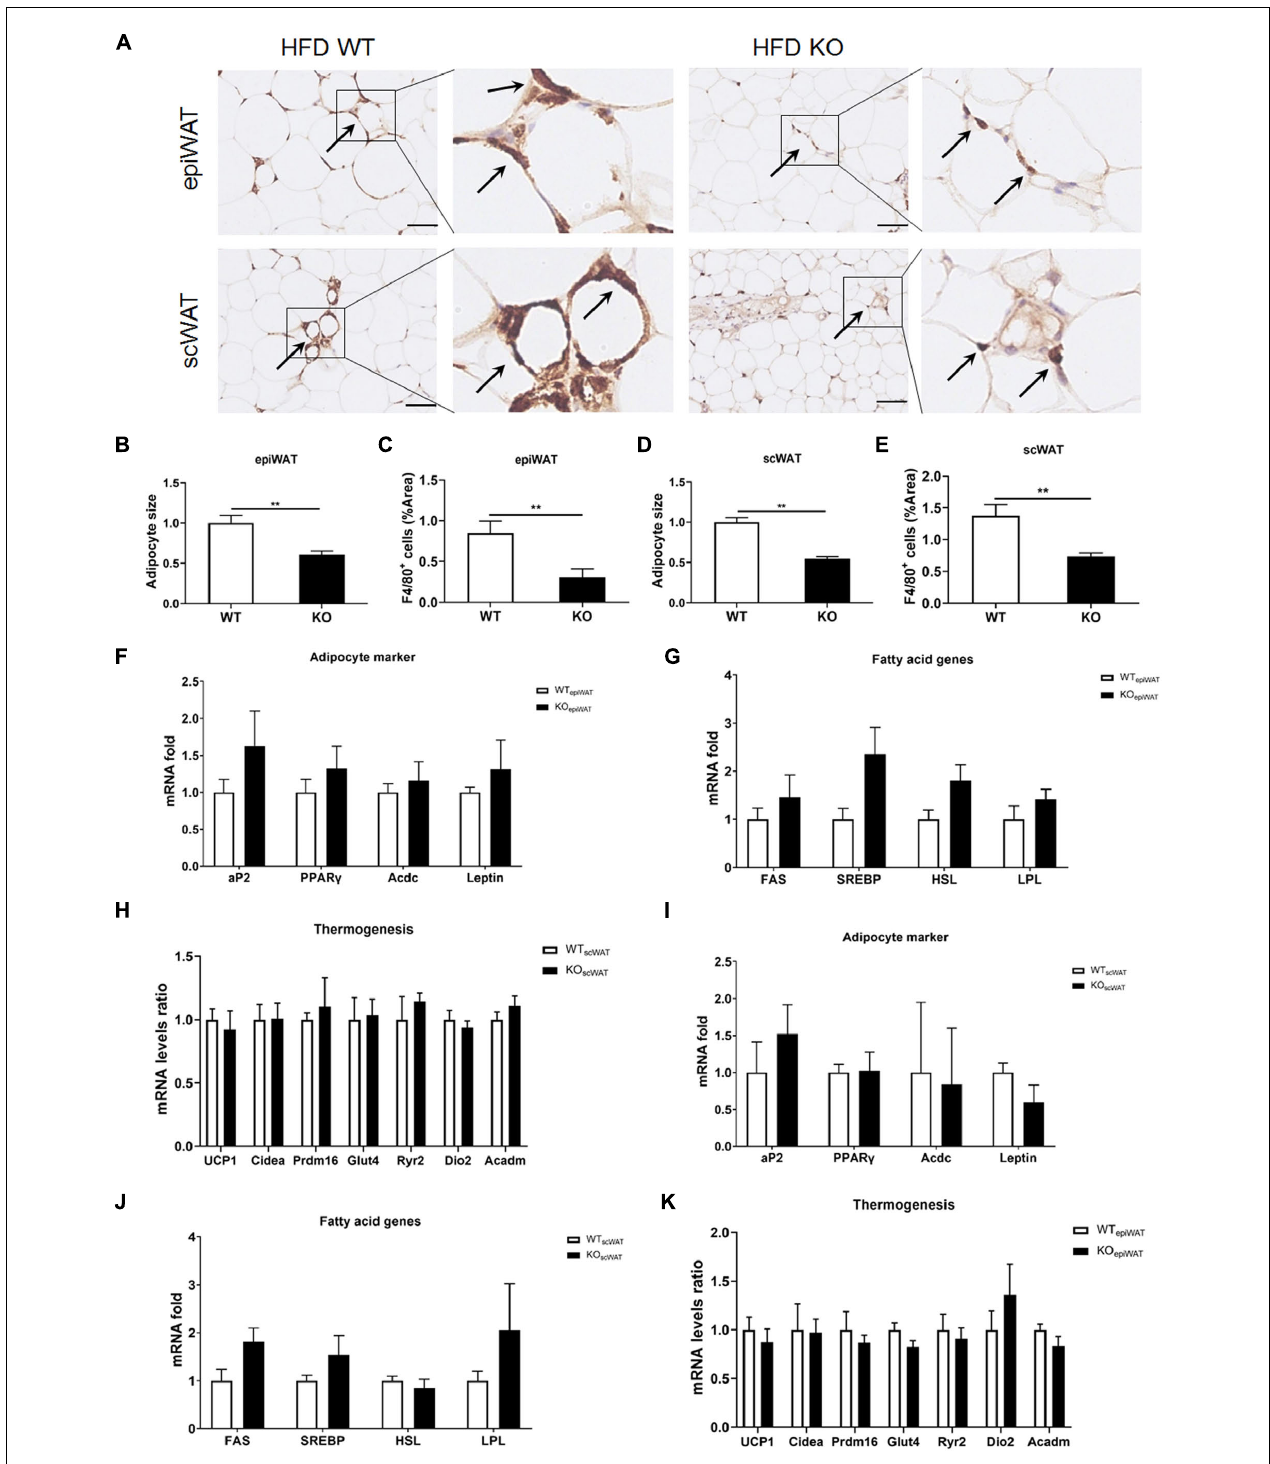
FIGURE 3 | LAMTOR1 depletion in macrophages reduces WAT mass. (A) IHC staining (F4/80) in the epiWAT and scWAT of HFD-fed mice. Black arrow represents the F4/80 + macrophages. (B–E) Quantification of adipocyte size and the F4/80 + macrophage/%area in the epiWAT and scWAT of HFD-fed mice. The IHC quantification is performed in a total of 36 images, with 3 images per mouse, and is presented as the percentage of the area of F4/80 + cells. (F–K) mRNA expression of adipocyte-specific genes, fatty acid genes (including both fat synthesis- and lipolysis-related genes) and thermogenesis in the epiWAT (F–H) and scWAT (I–K) of HFD-fed WT and LAMTOR1 MKO mice. The data are expressed as the mean ± SEM, n = 4–6. ** P < 0.01 vs. WT. epiWAT, epididymal white adipose tissue; HFD, high-fat diet; IHC, Immunohistochemistry; MKO, myeloid-specific knockout; scWAT, subcutaneous white adipose tissue; SEM, standard error of the mean; WT,